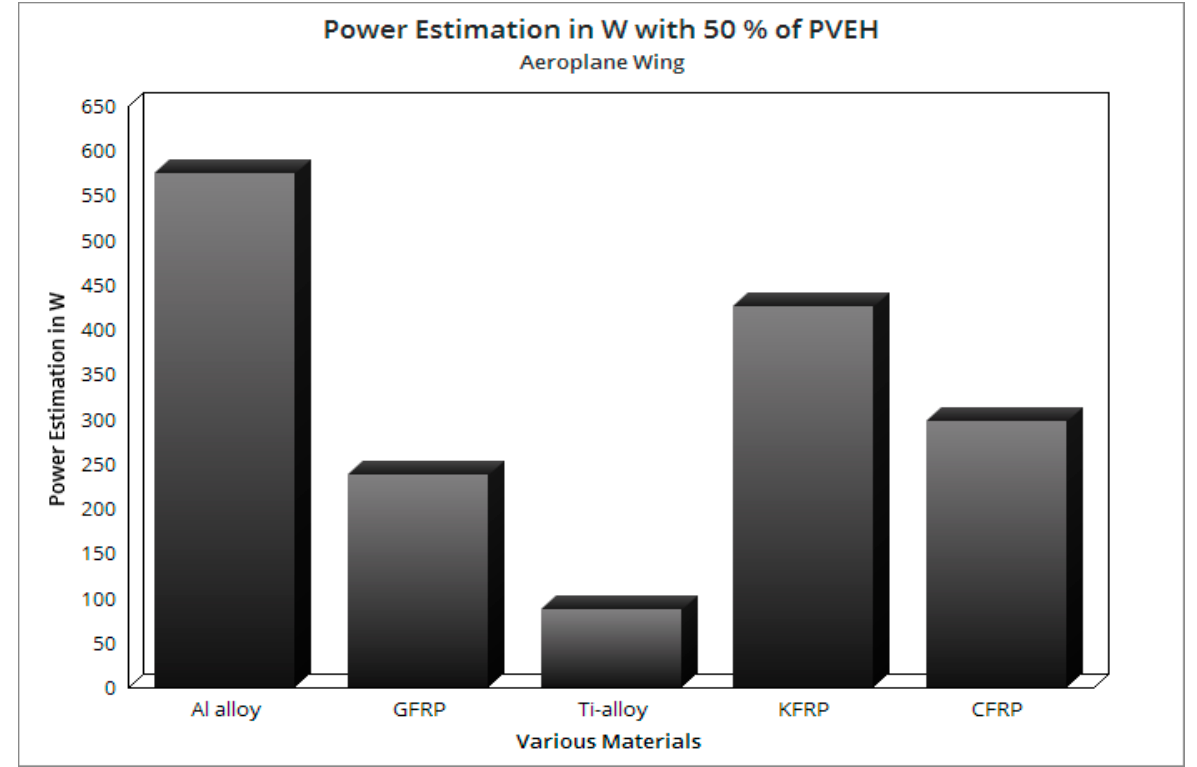
Figure 32. Power (P 0 ) in W with 50% attachment coverage—airplane wing.